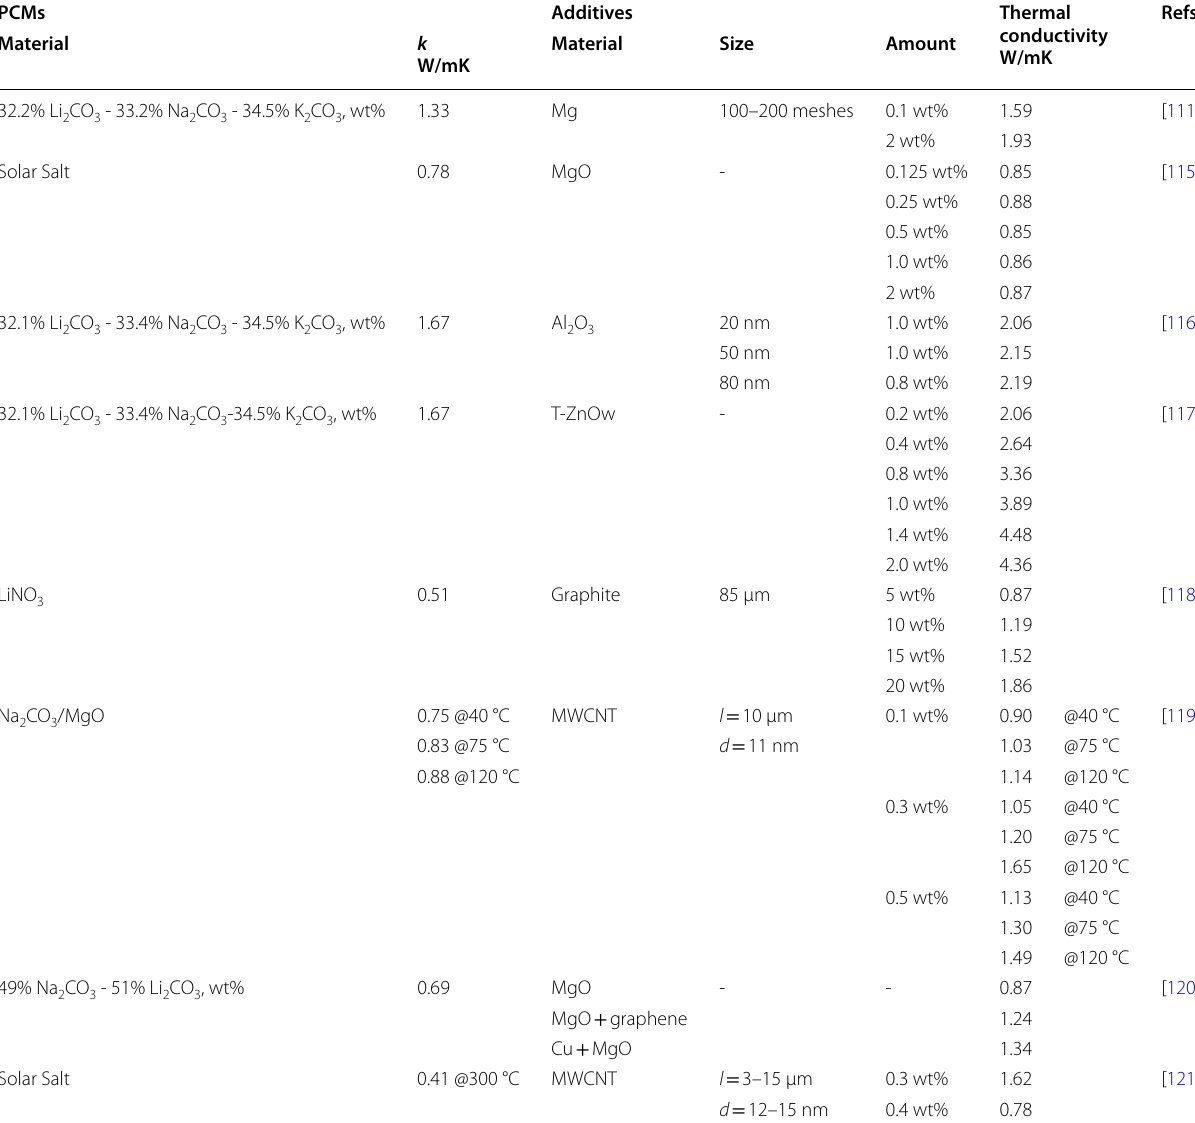
Table 7 Thermal conductivity of some composite PCMs embedded in highly thermal conductive particles PCMs Additives Thermal